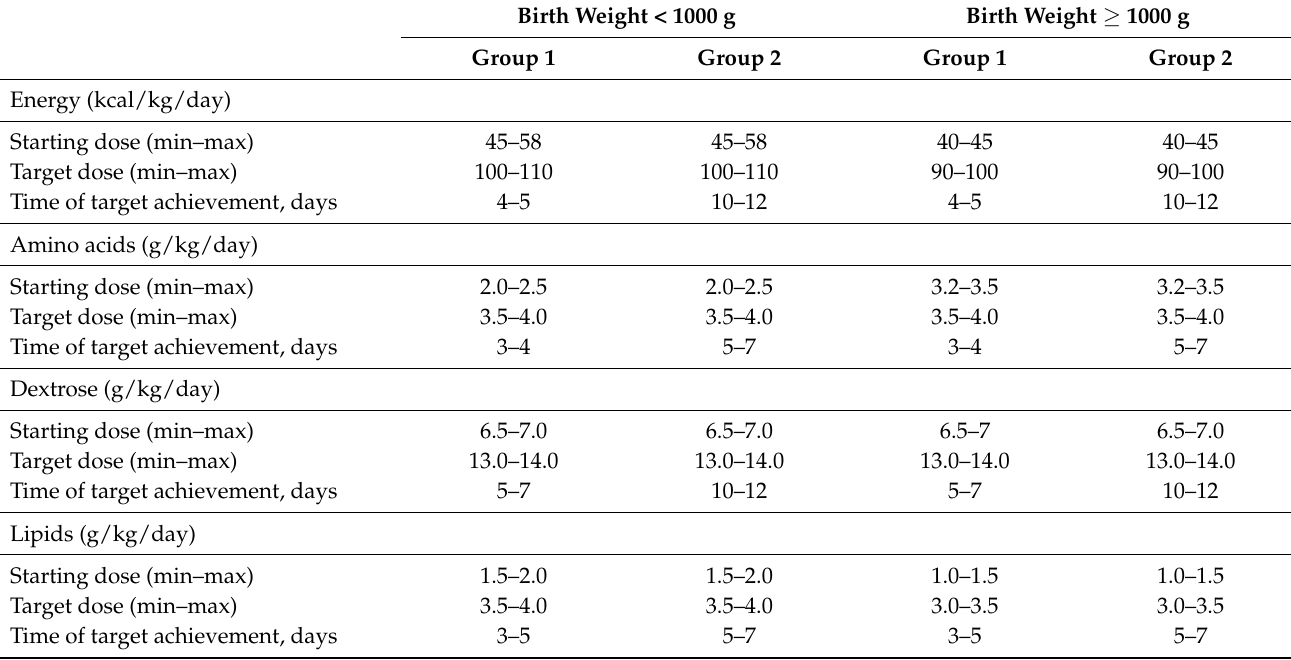
Table 1. Nutritional protocol of neonates included in the two study